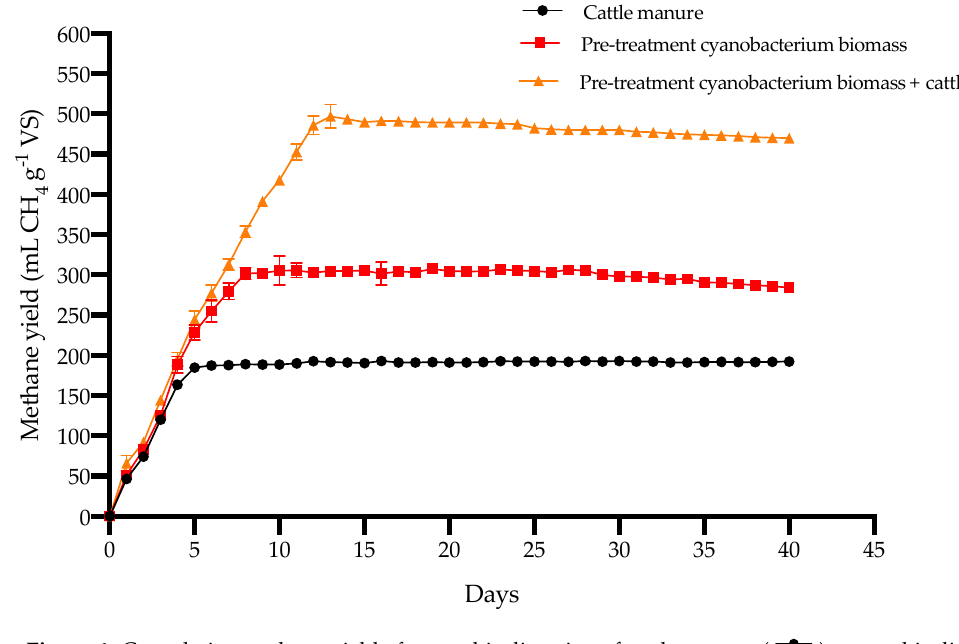
Figure 4. Cumulative methane yield of anaerobic digestion of cattle manure ( ); anaerobic digestion of pre ‐ treated Arthrospira platensis biomass ( ); and anaerobic co ‐ digestion of bovine manure + of pretreated Arthrospira platensis biomass ( ). Values are average ± SD (n = 3).